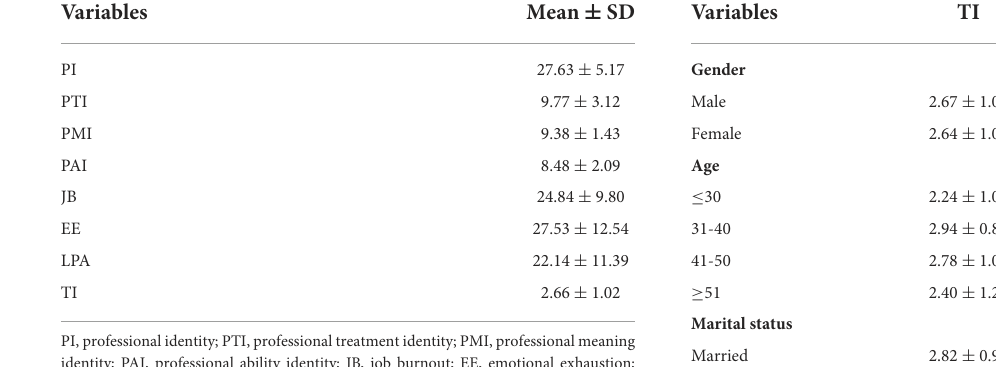
TABLE 2 Mean values of PI, JB, and TI. TABLE 3 Single factor analysis of